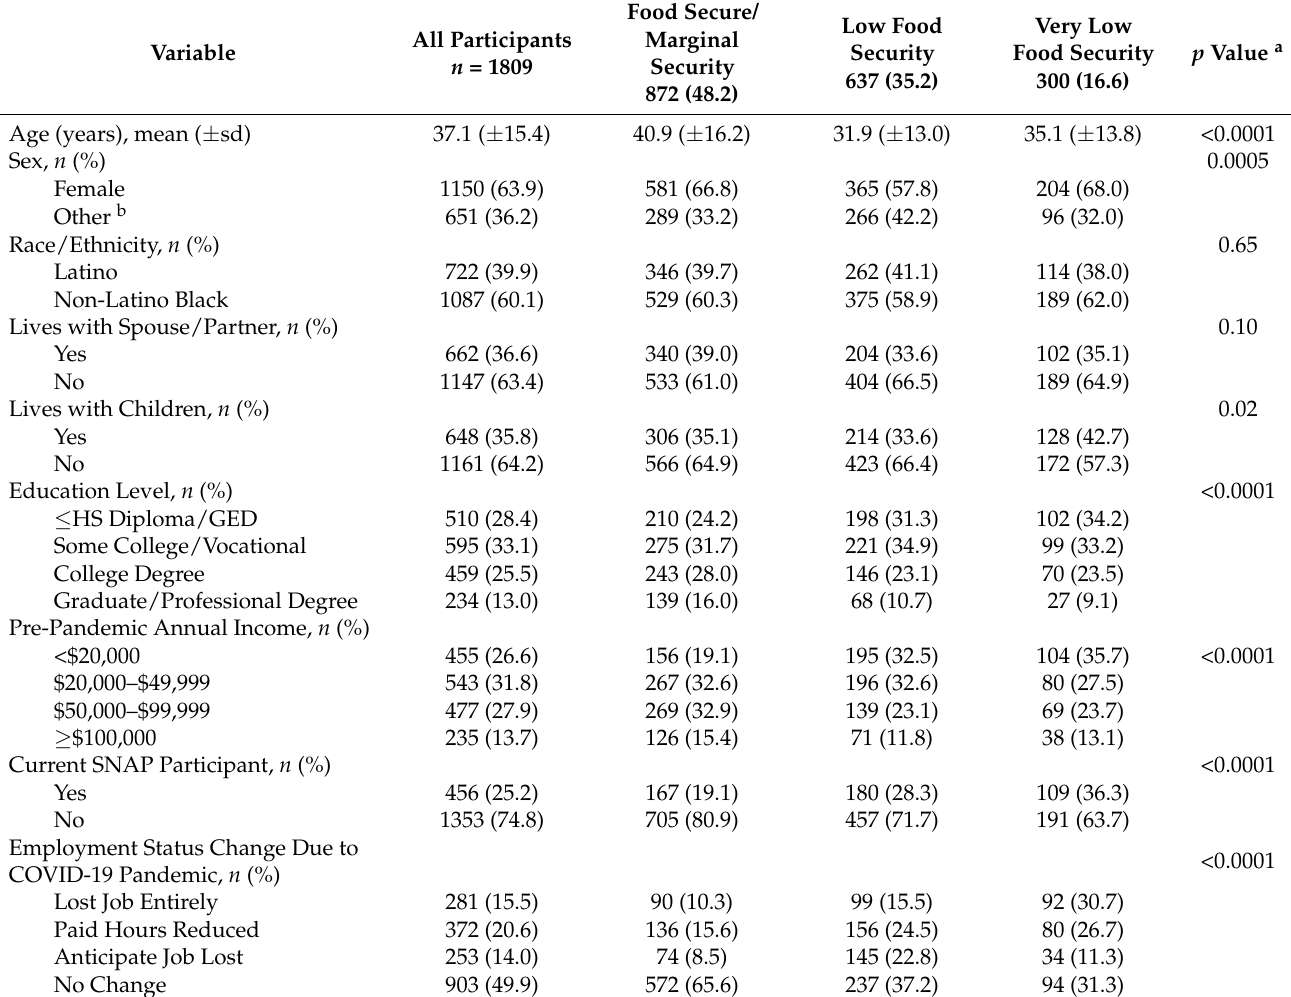
Table 1. Demographic Characteristics of Survey Participants by Food Security